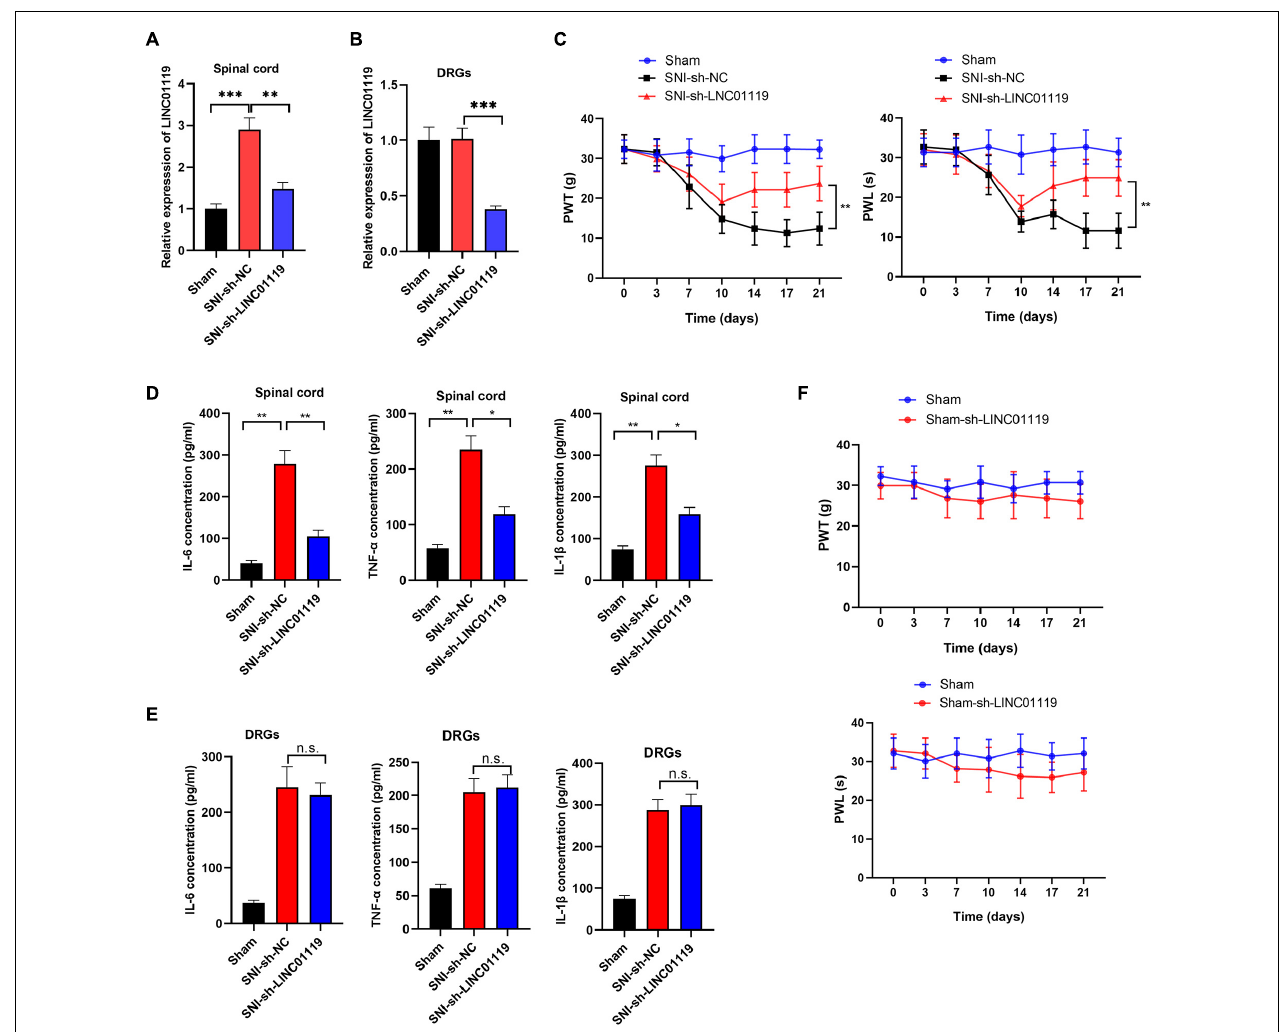
FIGURE 2 | LINC01119 causes NP in rats undergoing SNI (A,B) . LINC01119 was silenced in SNI rats after intrathecal injection of sh-LINC01119 vector in both spinal cord (A) and DRGs (B) , ** P < 0.01, *** P < 0.001, n = 3/group. (C) PWT (left) and PWL (right) were assessed in rats silenced with LINC01119, ** P < 0.01, n = 5/group. (D,E) The concentrations of IL–6, TNF– α , and IL-1 β in spinal cord (D) and DRGs tissues (E) of rats were detected by ELISA at day 14, * P < 0.05, ** P < 0.01, n = 3/group. (F) PWL and PWT were not altered by LINC01119 knockdown in sham rats without SNI surgery, n = 5/group.